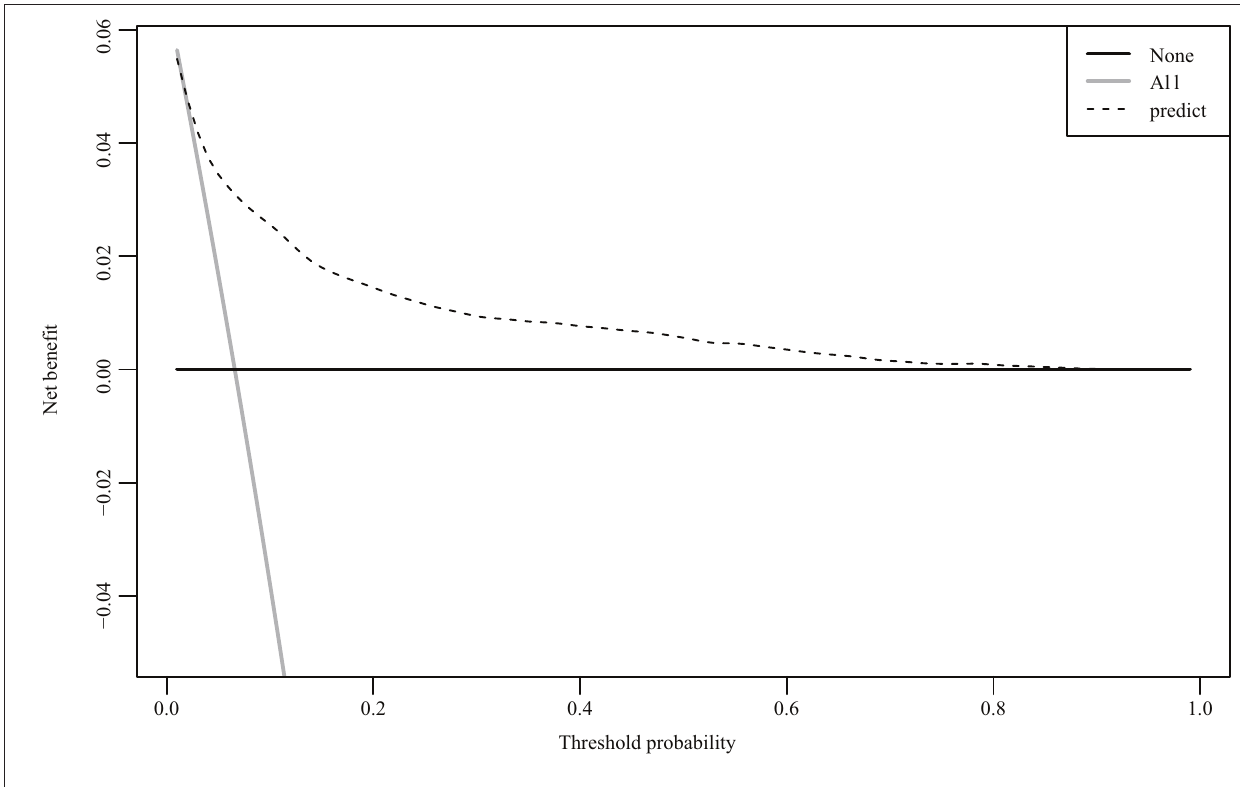
FIGURE 3 | Decision curve analysis curve for the